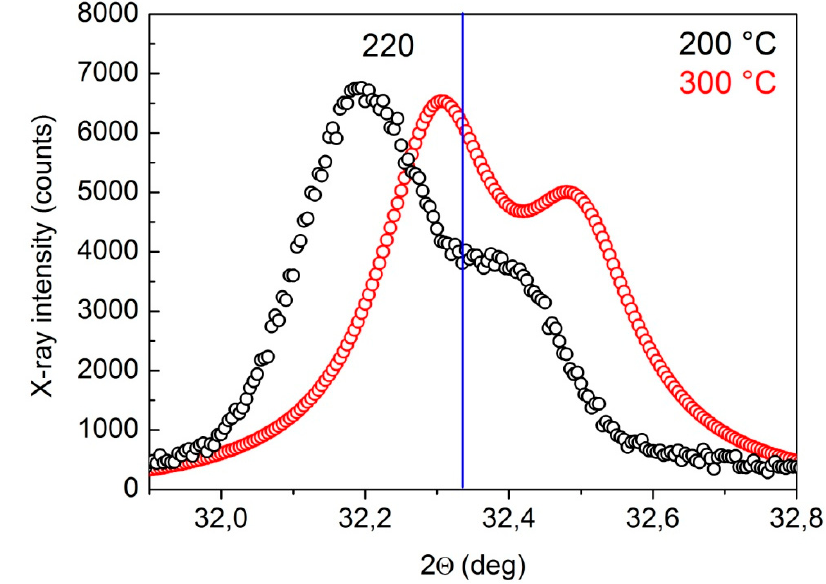
Figure 8. {220} peak profiles of samples welded with PHT of 200 and 300 °C and the same pass speed of 1.5 m/min. The vertical blue line indicates the peak position of base material (BM) free from the stresses arising from welding.